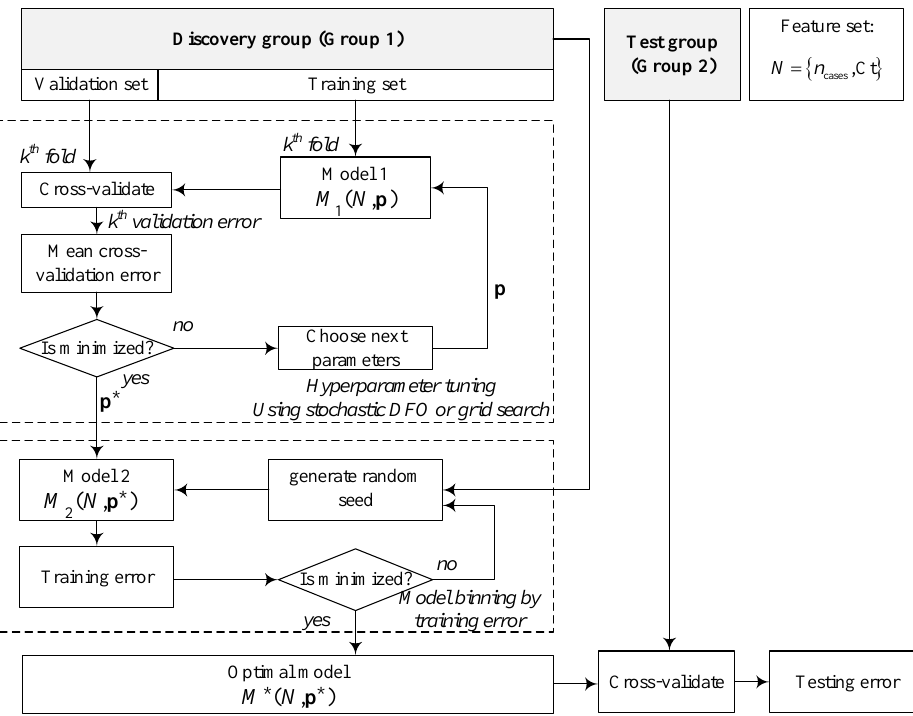
Figure 3. Cross-validation and hyperparameter determination scheme for model development. Fol- lowing the discovery group (Group 1), the inner loop tuned the model’s hyperparameters by mini- mizing the average k -fold cross-validation error using a stochastic direct search algorithm or a grid search. The second loop (following tuning) generates several models randomly and bins them by training error. The best model with the lowest training error is tested on the test group to obtain the testing